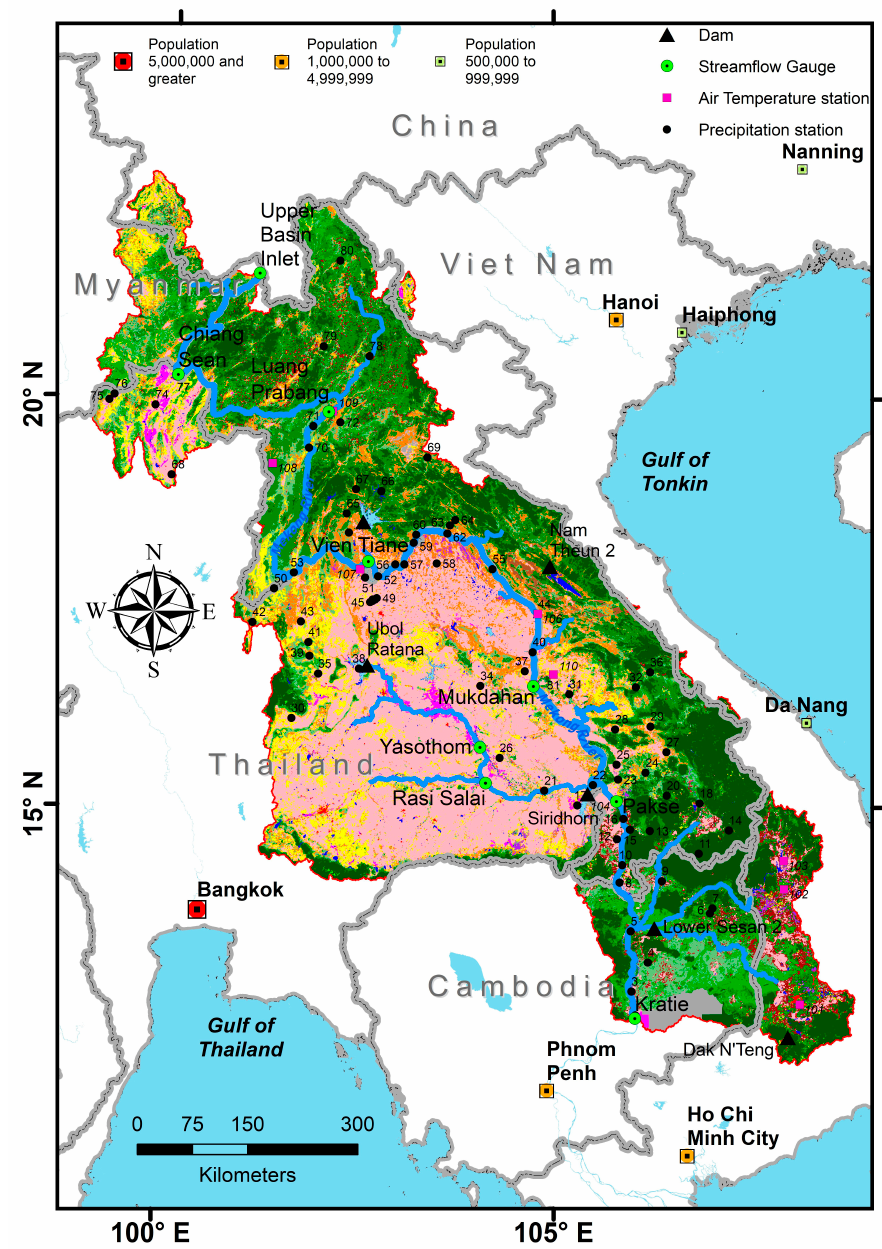
Figure 1. The Lower Mekong River Basin. Streamflow gauges (described in Table 1) follow the Lower Mekong River Basin subareas, as presented by Rossi et al. [14]. Cities with population classes obtained from the Environmental Systems Research Institute, Inc. (ESRI) World Populated Places layer (https://www.arcgis.com/home, accessed on 25 May 2018) are depicted in red (greater than 5 million), orange (1-5 million), and light green (0.5–1 million).